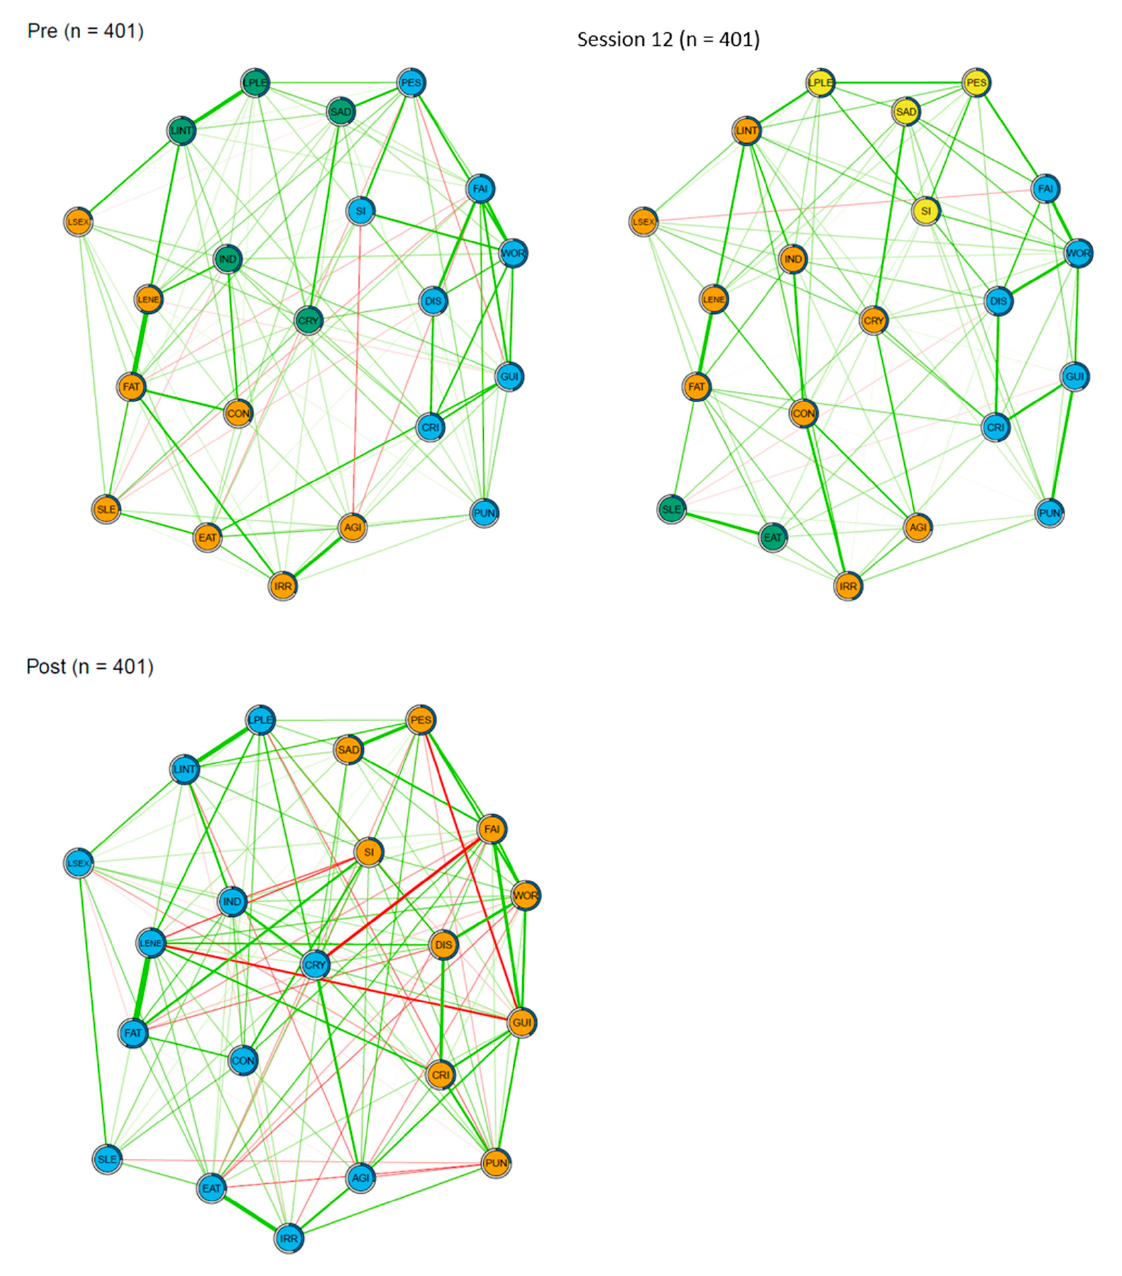
Figure 1. EBIC gLasso networks of BDI symptoms before CBT, after 12 sessions of CBT, and after CBT ( n = 401). Note. Abbreviations are listed in Table 1. Green lines represent positive associations and thicker lines represent stronger associations between symptoms. The colors of the nodes represent different communities. Blue rings around the nodes represent the proportion of explained variance of that symptom.